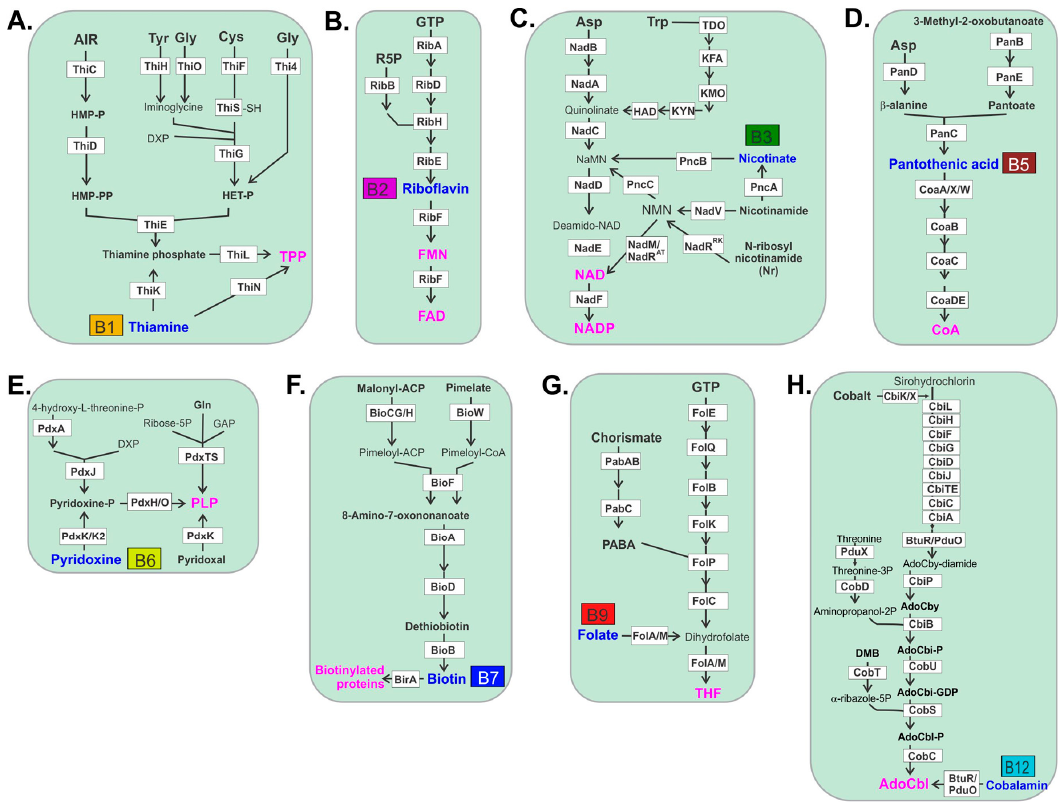
Figure 1. Biochemical pathways for vitamin/cofactor biosynthesis in human gut microbiome. ( A ) thiamine pyrophosphate (TPP); ( B ) Flavin MonoNucleotide/Flavin Adenine Dinucleotide FMN/FAD; ( C ) Nicotinamide Adenine Dinucleotide (Phosphate) NAD/NADP; ( D ) coenzyme A (CoA); ( E ) pyridoxal-phosphate (PLP); ( F ) biotin; ( G ) tetrahydrofolate (THF); ( H ) adenosylcobalamine (AdoCbl). Enzymes are shown in white boxes. B-vitamins/cofactors are in blue/magenta text.